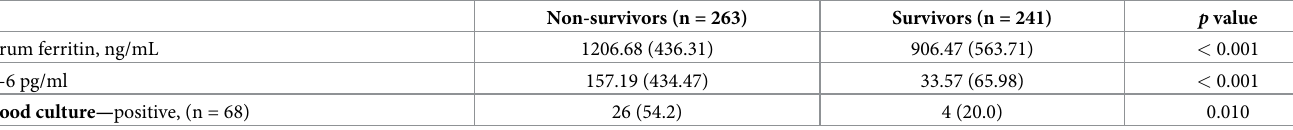
mechanical ventilation. Among survivors, use of an oxygen reservoir bag (44.4%) or high-flow